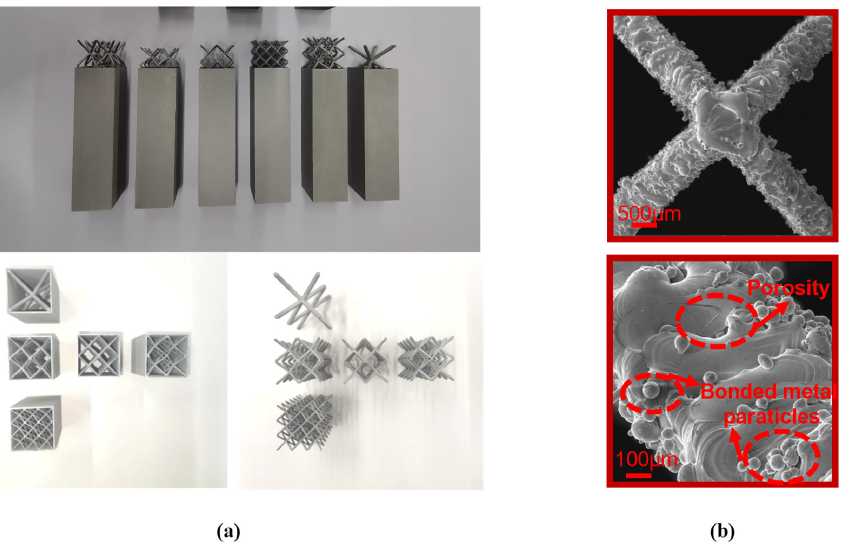
Figure 5. ( a ) Macroscopic morphology of the experimental specimen; ( b ) high magnification SEM image of the surface morphology of the sample.